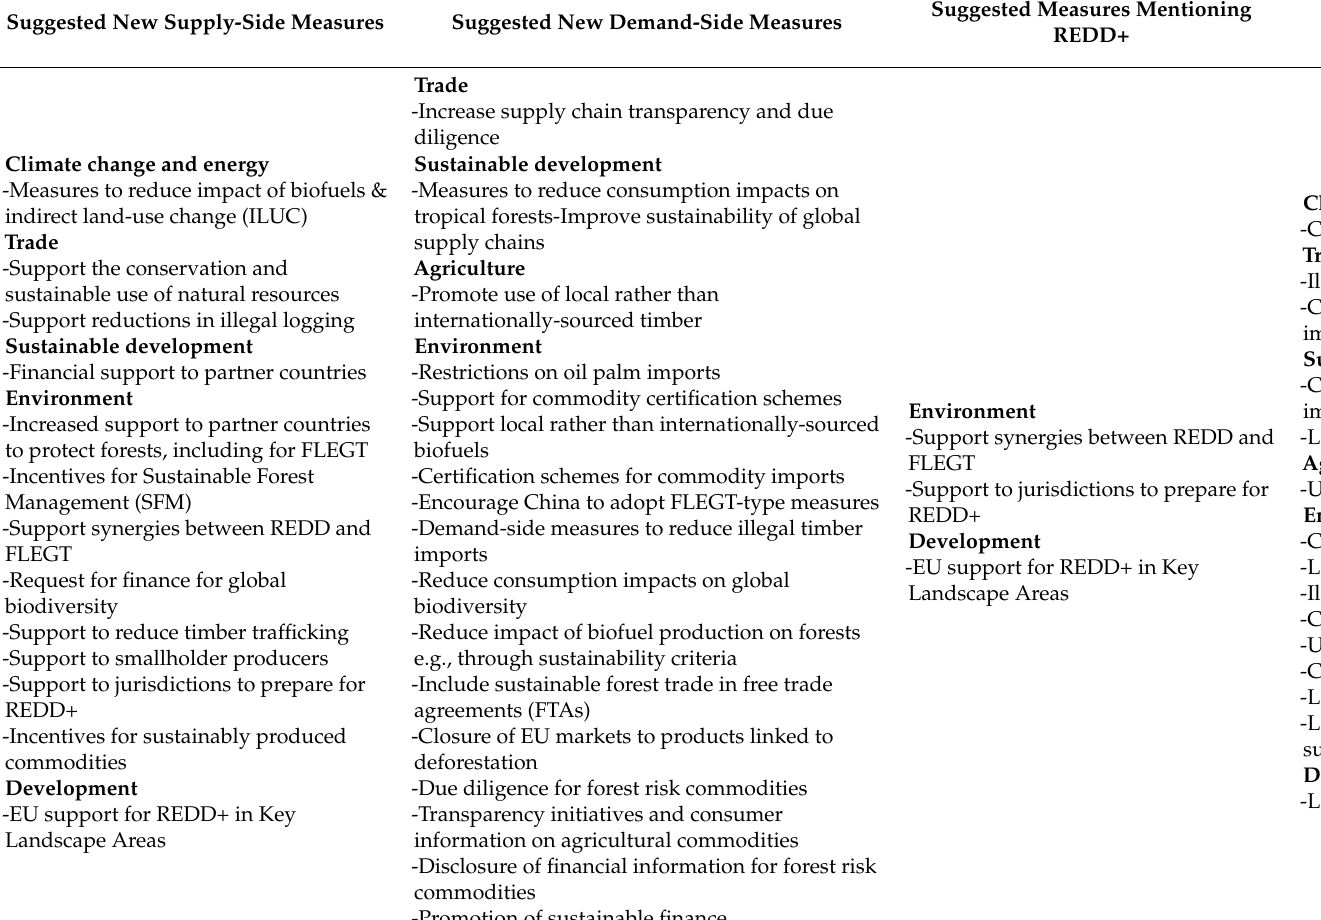
Table 2. New suggested policy measures to combat tropical deforestation within documents published by or for EU policy-makers. Suggested New Supply-Side Measures Suggested New Demand-Side Measures